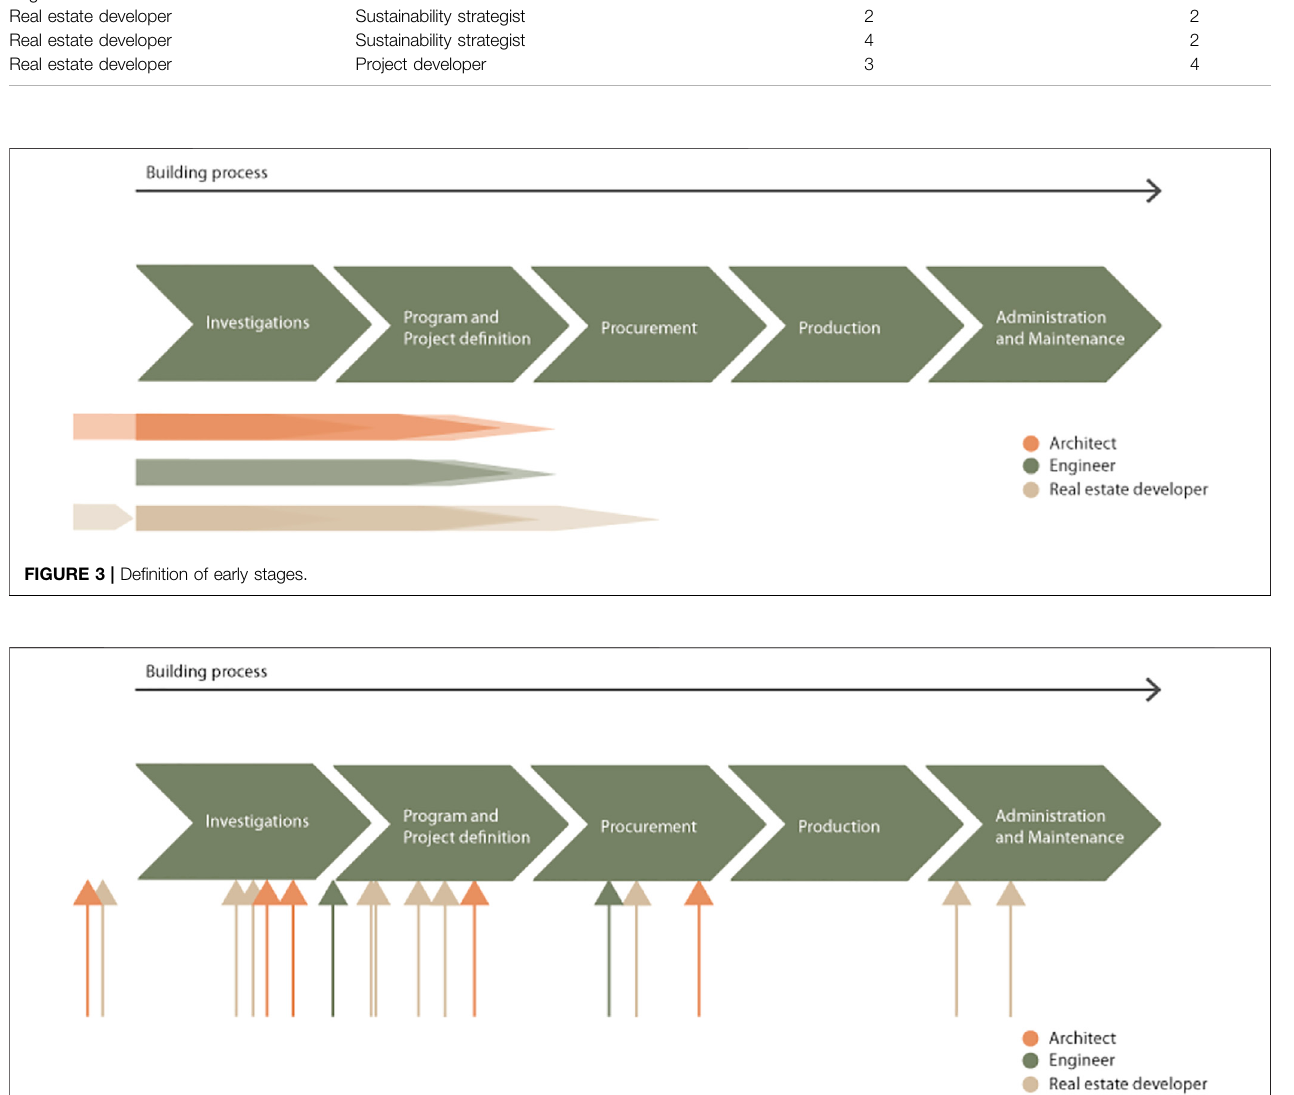
FIGURE 4 | The interviewees suggestions on when to conduct early-stage LCA.